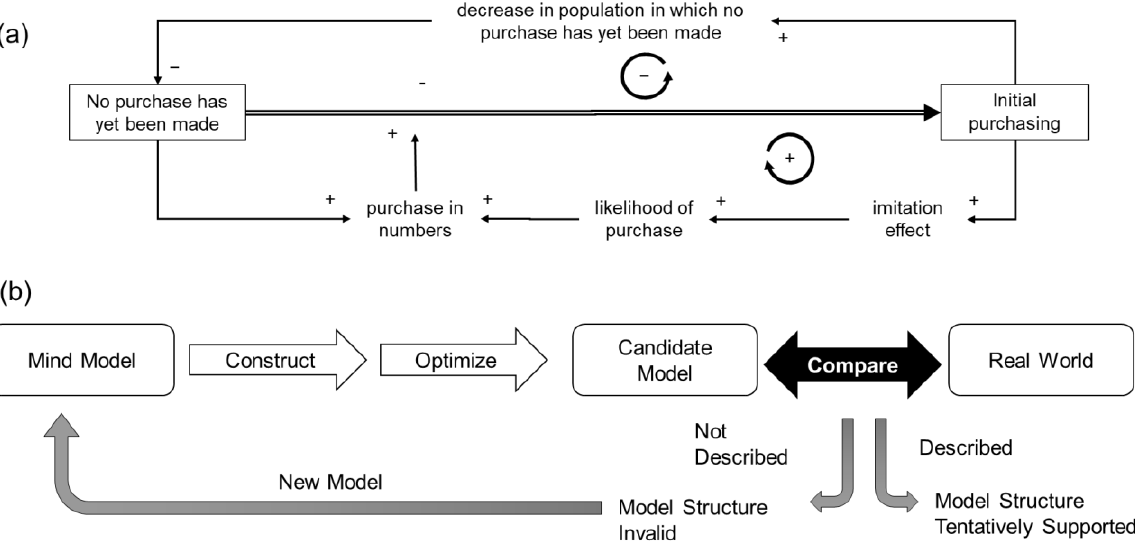
Figure 1. ( a ) Representation of Bass’s new product growth model by a system dynamics concept. ( b ) Conceptual schema of the approach employed in the current study.